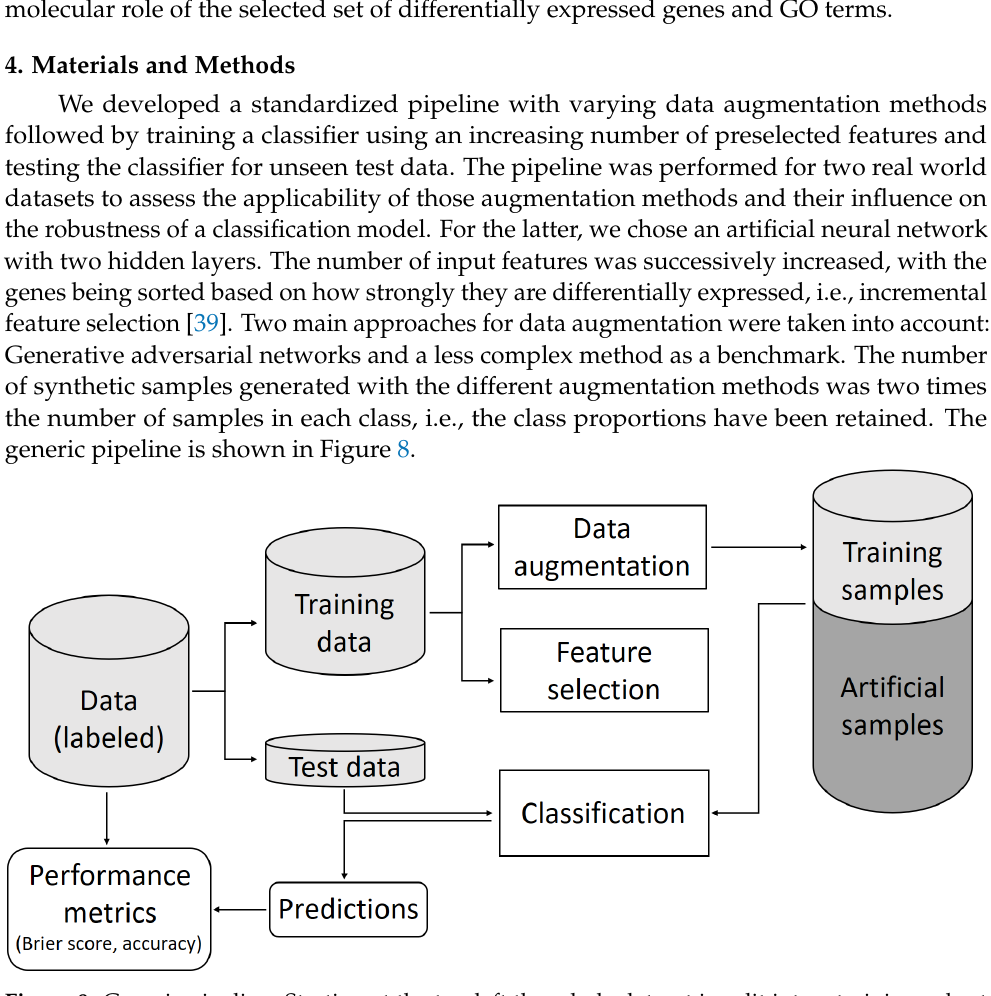
Figure 8. Generic pipeline: Starting at the top left the whole dataset is split into a training subset and a test subset. The training subset is then augmented using various augmentation methods. Following a feature selection, the augmented dataset with a reduced number of genes is used to train a classification network which itself is used to classify the so-far unseen test